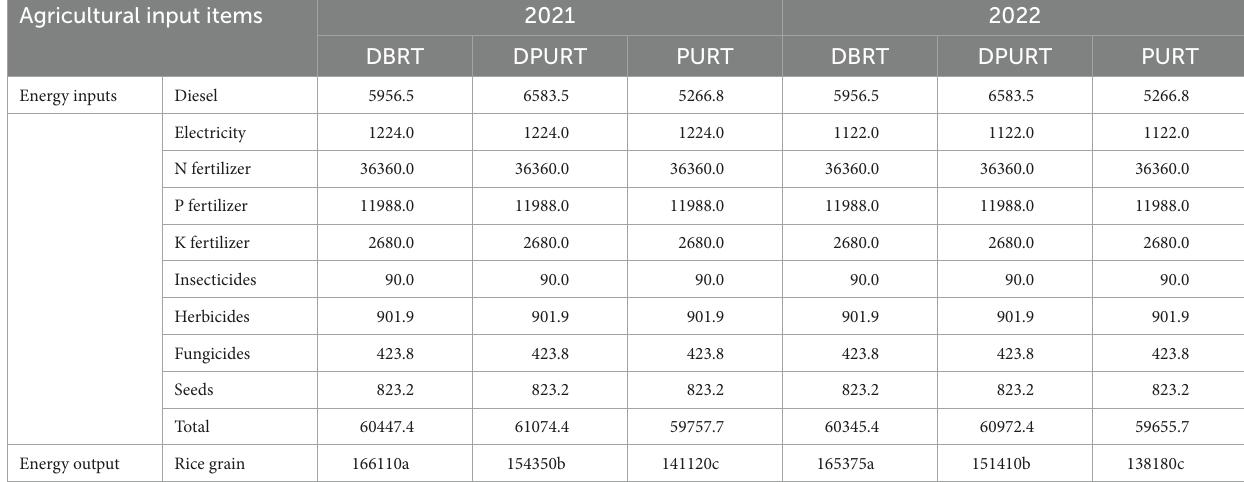
TABLE 7 Energy inputs and energy output (MJ ha − 1 ) in the three tillage treatments in 2021 and 2022. Agricultural input items